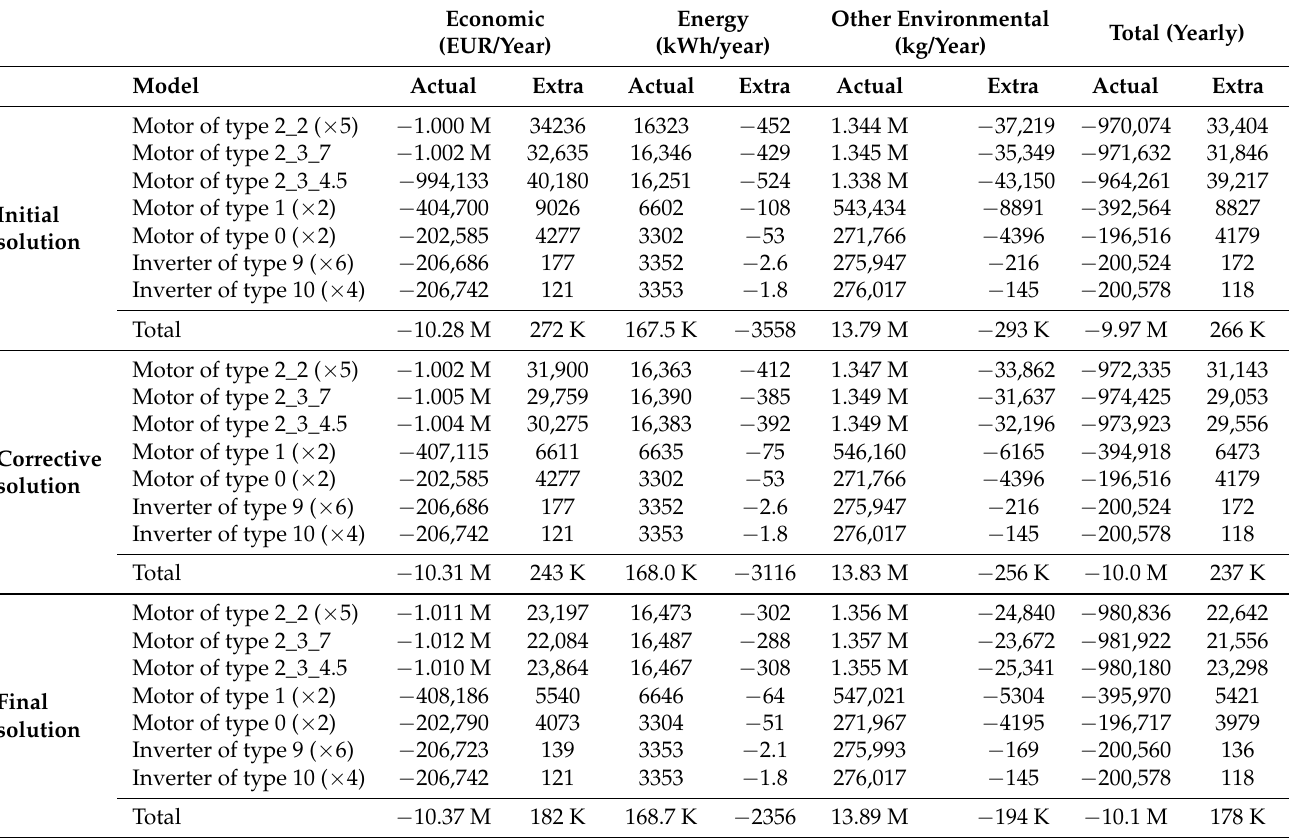
Table 28. Total KPIs with respect to components with summation for the whole production line, yielded from training all models for